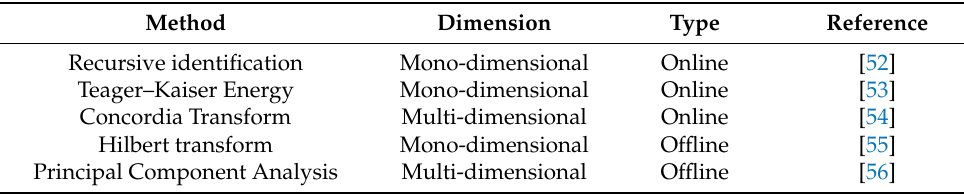
Table 4. Current demodulation